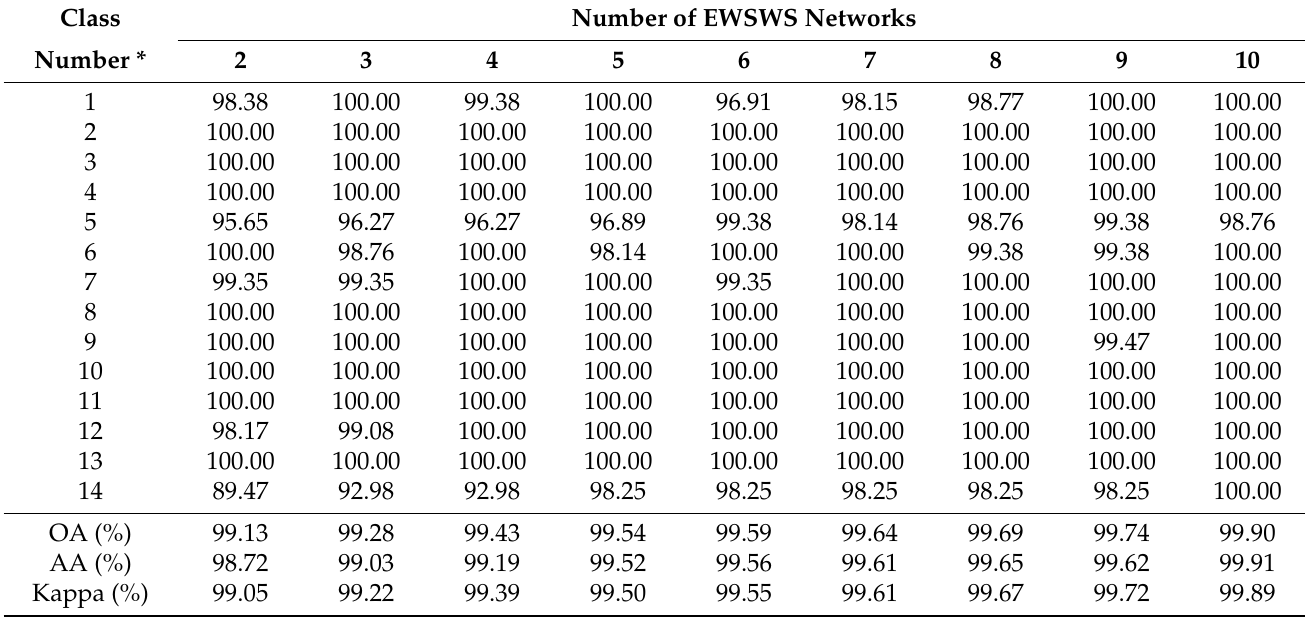
Table 6. Classification results with different numbers of EWSWS networks with the Botswana dataset.